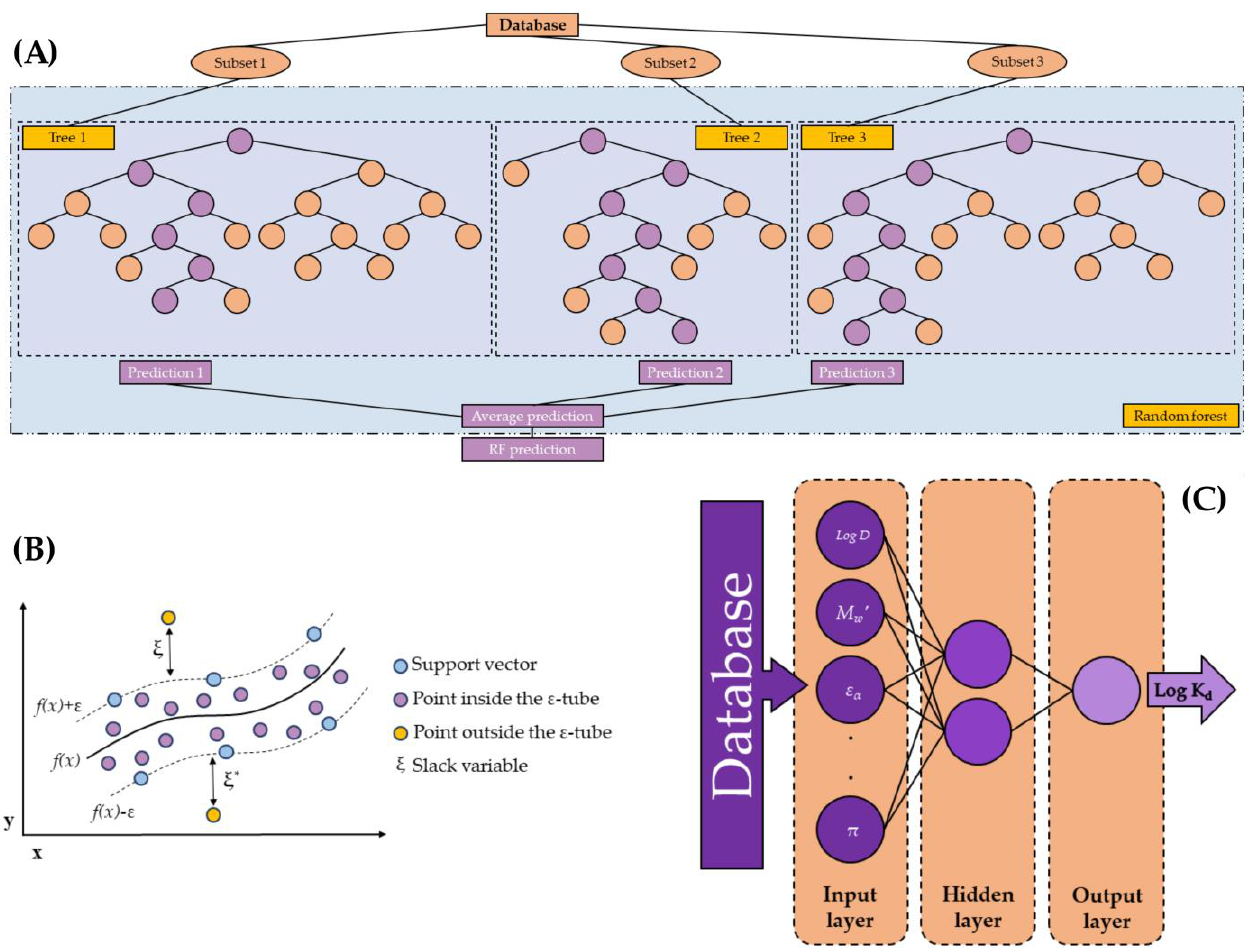
Figure 1. Schemes of the different ML models developed in this research: ( A ) RF model (in regression mode)—inspired by the figure of Yang et al. (2019) [55]; ( B ) SVM model—inspired by the figure of Sarraf Shirazi and Frigaard (2021) [56]; and ( C ) ANN model—inspired by the figures of Moldes et al. (2016) and Zou et al. (2021)